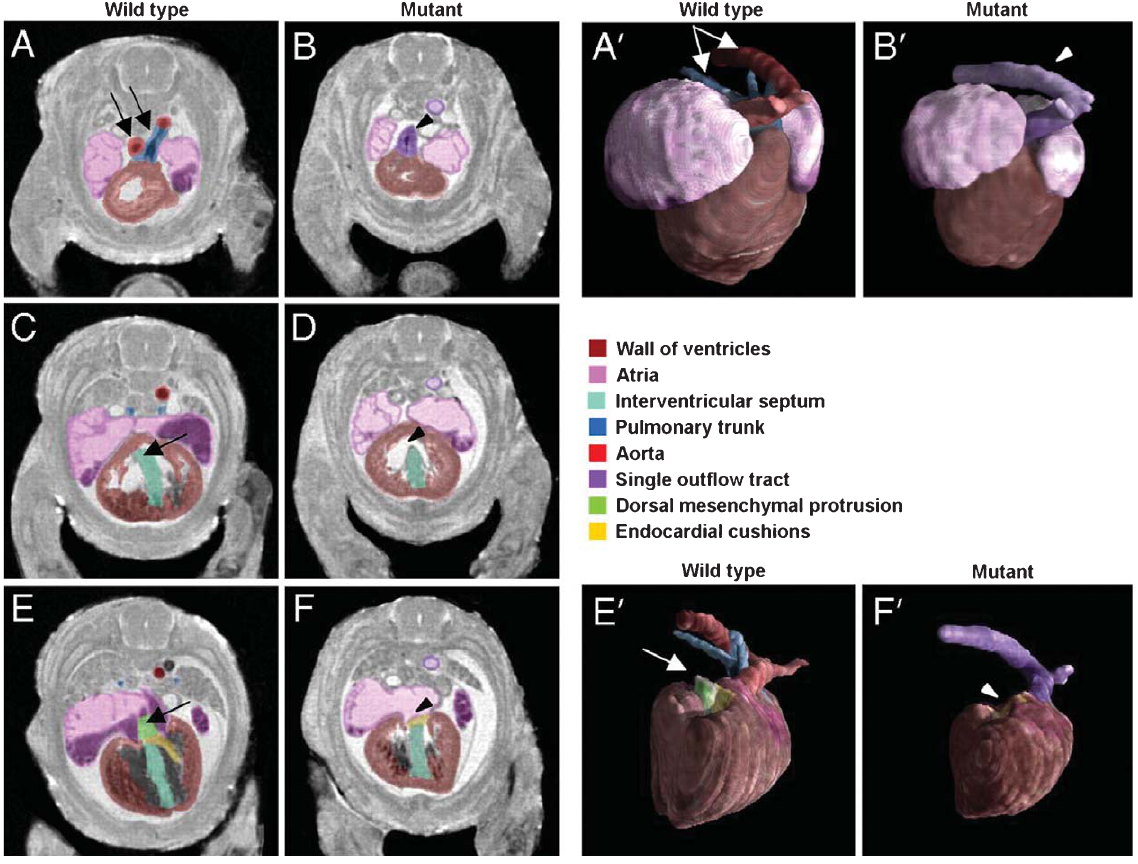
Fig. 15. MRM imaging at 19.5 (cid:1) m resolution allows discerning cardiac defects in a mouse with conditional ablation of Smo receptor gene. From most cranial to most caudal slices, the arrows point to (A, B) outflow tract abnormalities in the mutant mouse, which fails to branch into the aorta and pulmonary trunk (C, D) an open septum defect (E, F), absence of DMP in mutant mouse. (A’, B’) present surface rendering of the segmented heart (ventral view) and abnormal outflow tract in the mutant in comparison to the wild type control. (E’, F’) illustrate the absence of DMP (in a dorsal view of the heart). Reproduced with permission from [91] Copyright 2008 National Academy of Sciences, USA